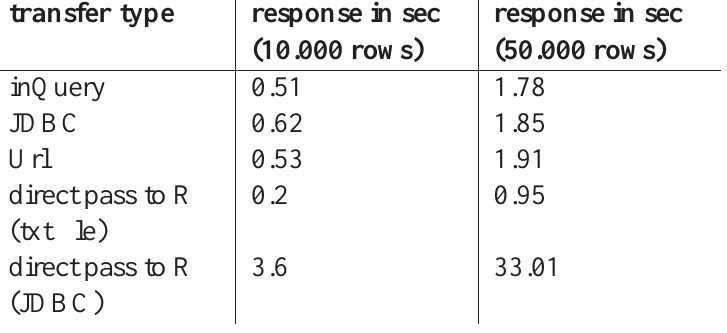
Table 4: Measurement of response time of test